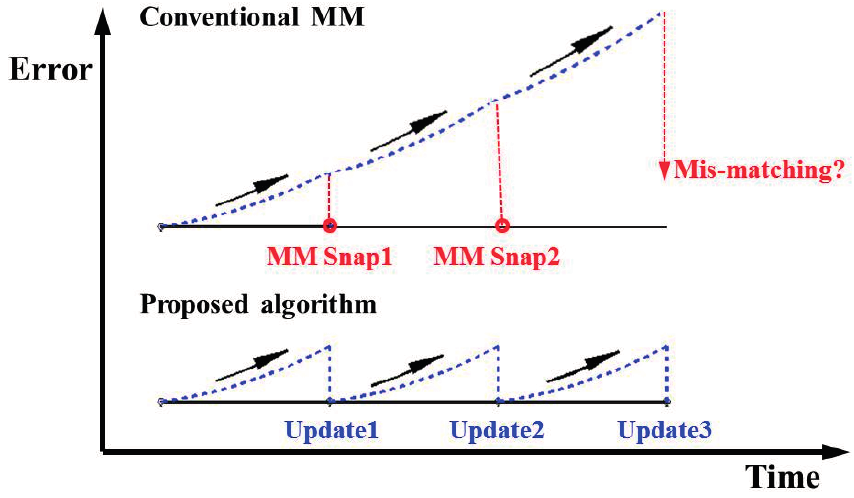
Figure 1. The comparison between conventional Map Matching (MM) and the proposed algorithm.